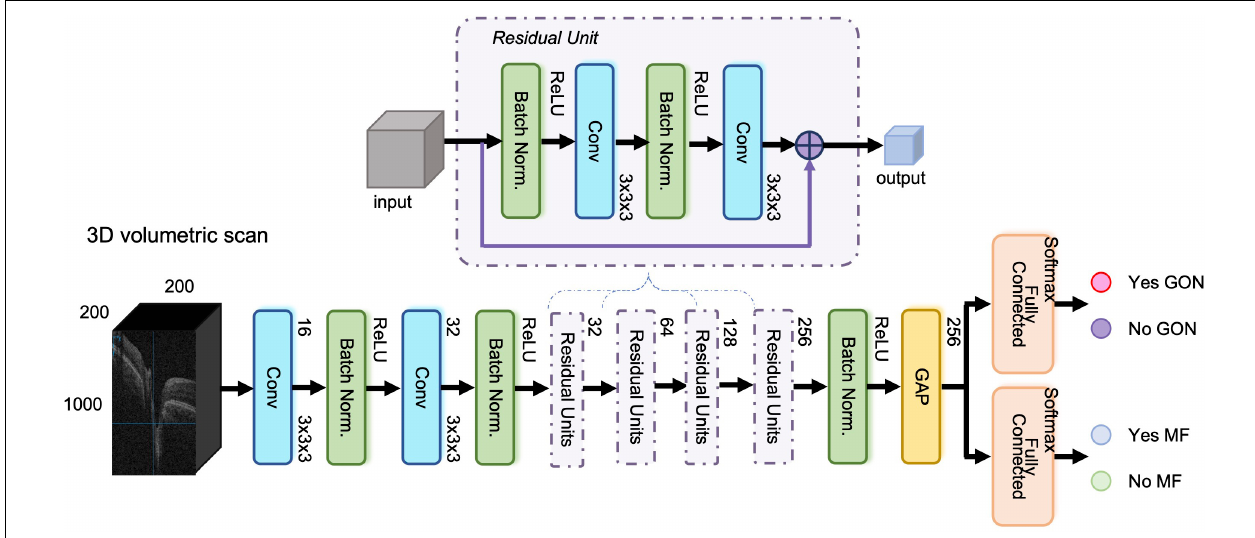
FIGURE 1 | The structure of the three-dimensional (3D) multi-task deep learning model. The proposed network included three modules, (1) shared feature extraction module, (2) glaucomatous optic neuropathy (GON) classification module, and (3) myopic features (MF) detection module, respectively. It was built based on ResNet-37 network with 3D convolutional layers and global average pooling layer. The input was an OCT volumetric scan of size 200 × 1000 × 200 pixels after image pre-processing and the output was Yes/No GON and Yes/No MF.